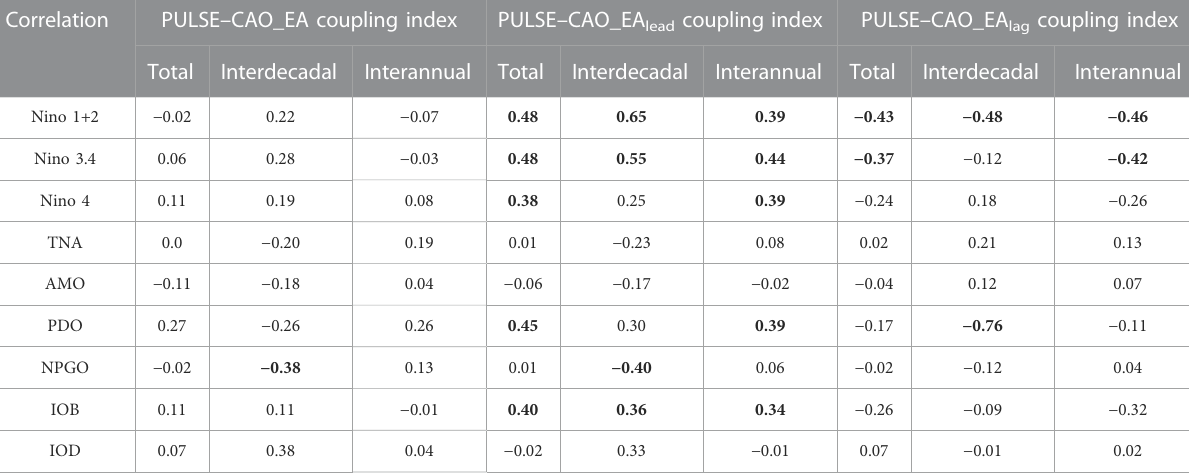
TABLE 2 As in Table 1, but for the PULSE – CAO_EA coupling indices.